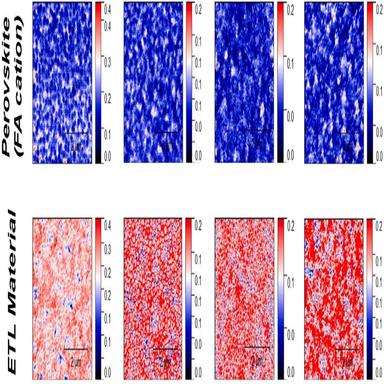
Droplets of diiodomethane and water on the surface of Cs0.12FA0.88PbI3 and Cs0.12FA0.88PbI3/1–4 stacks (a). IR s-SNOM mapping images for Cs0.12FA0.88PbI3/ 1–4 stacks at the frequencies of 1048 cm− 1 characteristic for Cs0.12FA0.88PbI3 and 1650 cm− 1 corresponding to C=O vibration in 1–4.